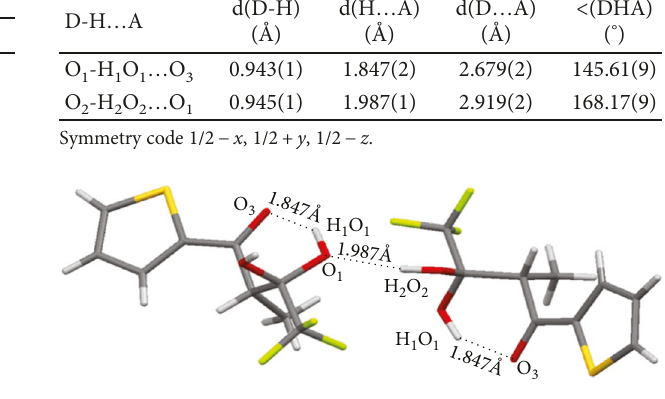
Table 1: Crystallographic data and structure re fi nement parameters of 3.